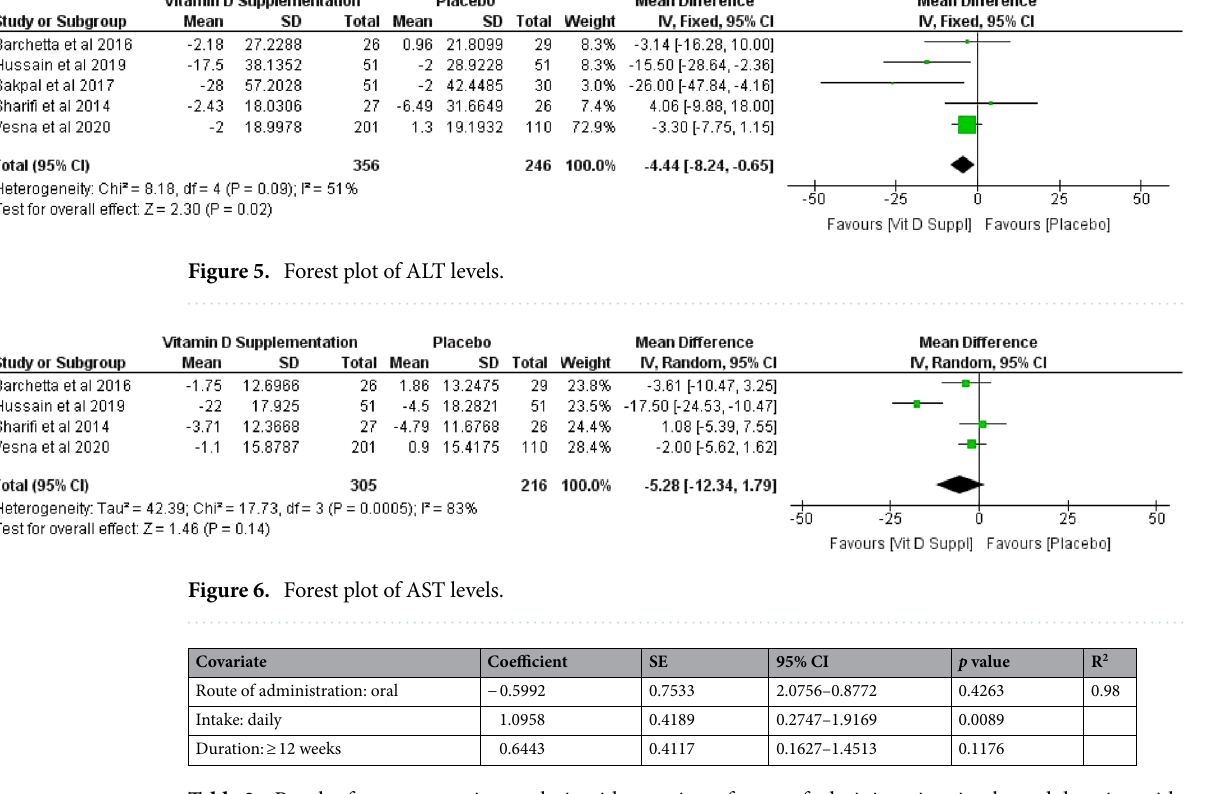
Table 2. Result of meta-regression analysis with covariate of route of administration, intake and duration with HOMA-IR. SE Standard error of coefficient, CI Confidence interval, R 2 R Square.